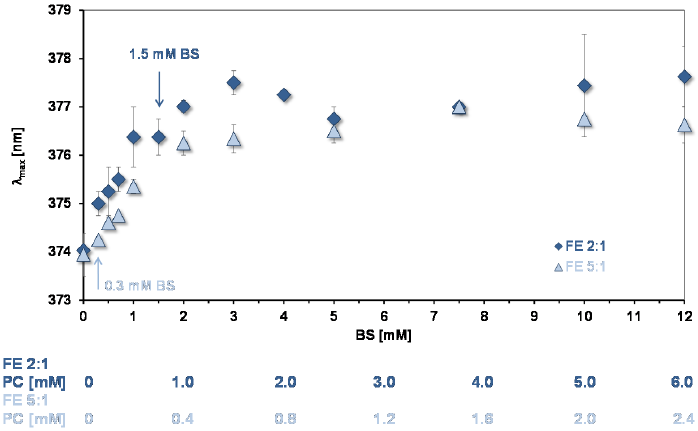
Figure 5. Bathochromic shift of peak B as a function of mixed micelle concentration (pH = 7.15). The arrows show the concentration of micelles used in the experiments of quercetin uptake by CaCo-2/TC7 cells. The OA concentrations relative to the BS concentrations are as in Table 1.